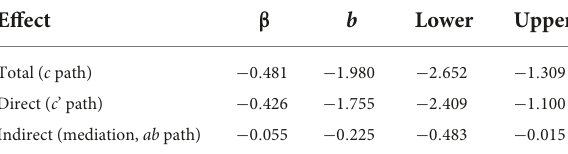
TABLE 6 Mediation effects of distress on the relationship between pain intensity and ADLs controlling for age, N = 123.